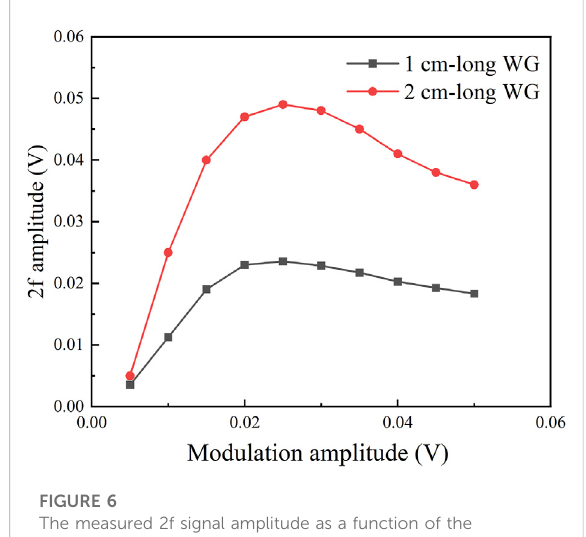
FIGURE 6 The measured 2f signal amplitude as a function of the modulation amplitude of the sinewave signal at a CH 4 concentration level of 10 5 ppmv for the 1 cm- and 2 cm-long